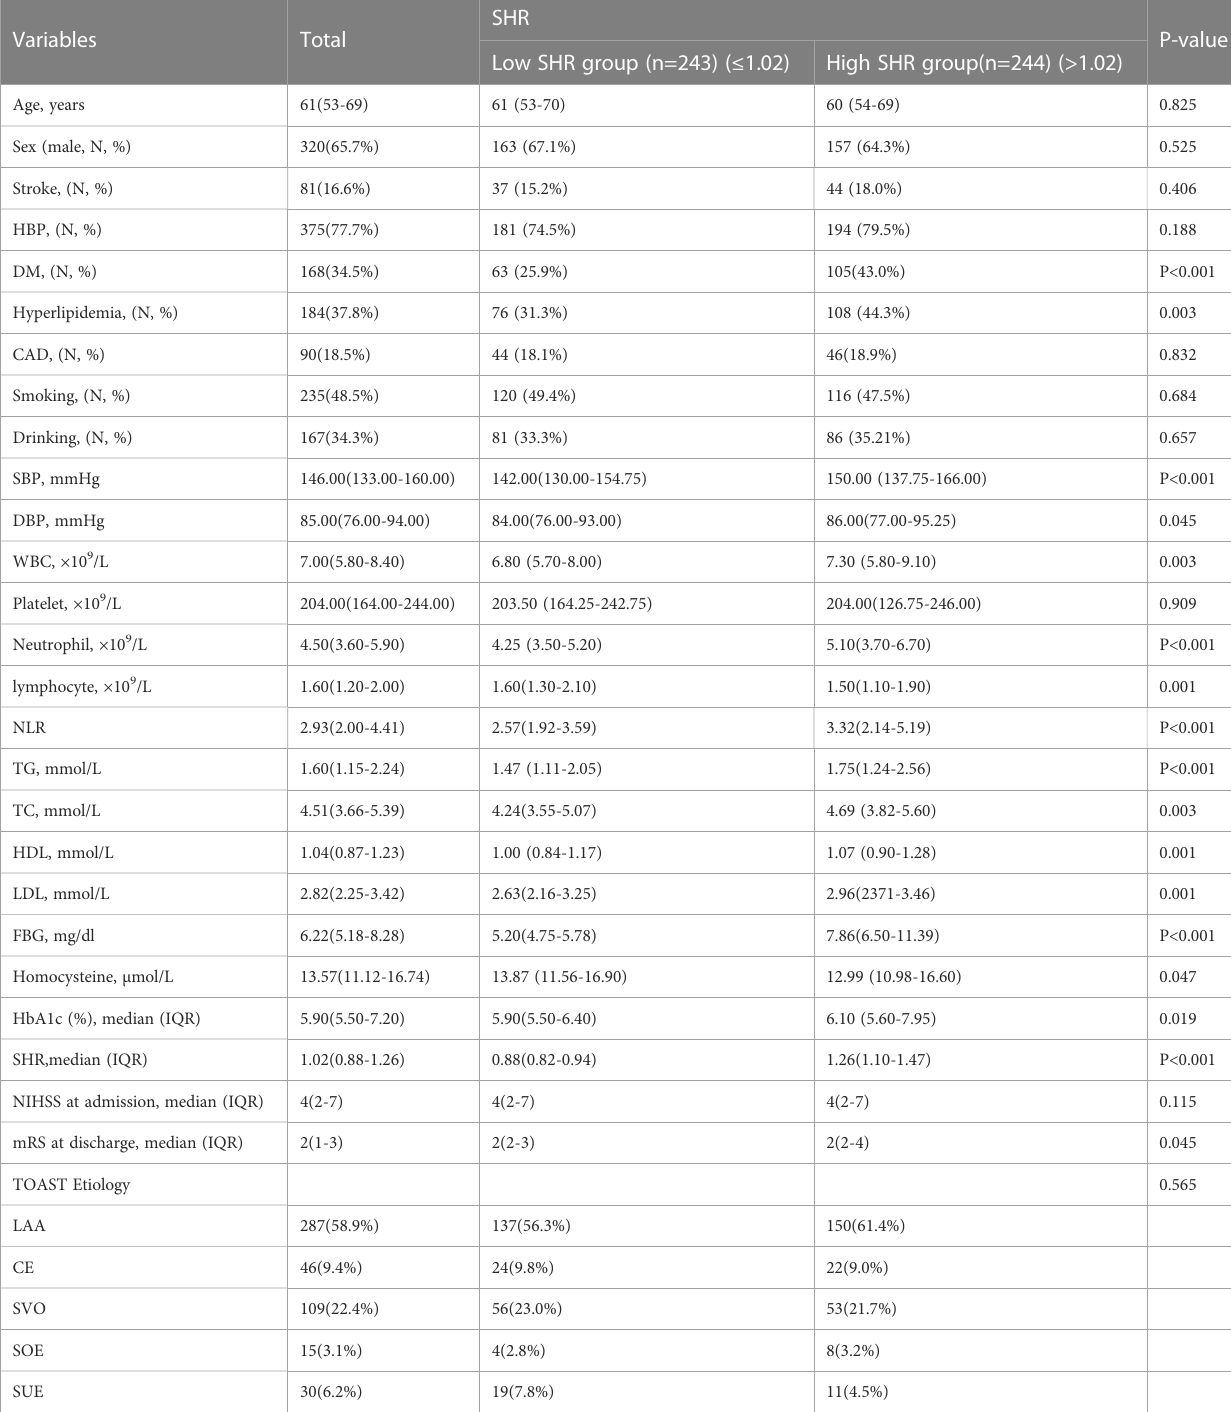
TABLE 1 Baseline characteristics of patients with ischemic stroke according to different SHR levels.